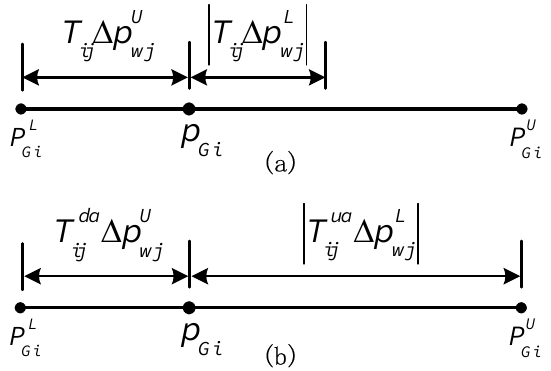
Figure 1. ( a ) Employing the same variable T ij to model the upward and downward adjustment from i th generator; ( b ) Employing different variables, T ua adjustment of i th dispatchable